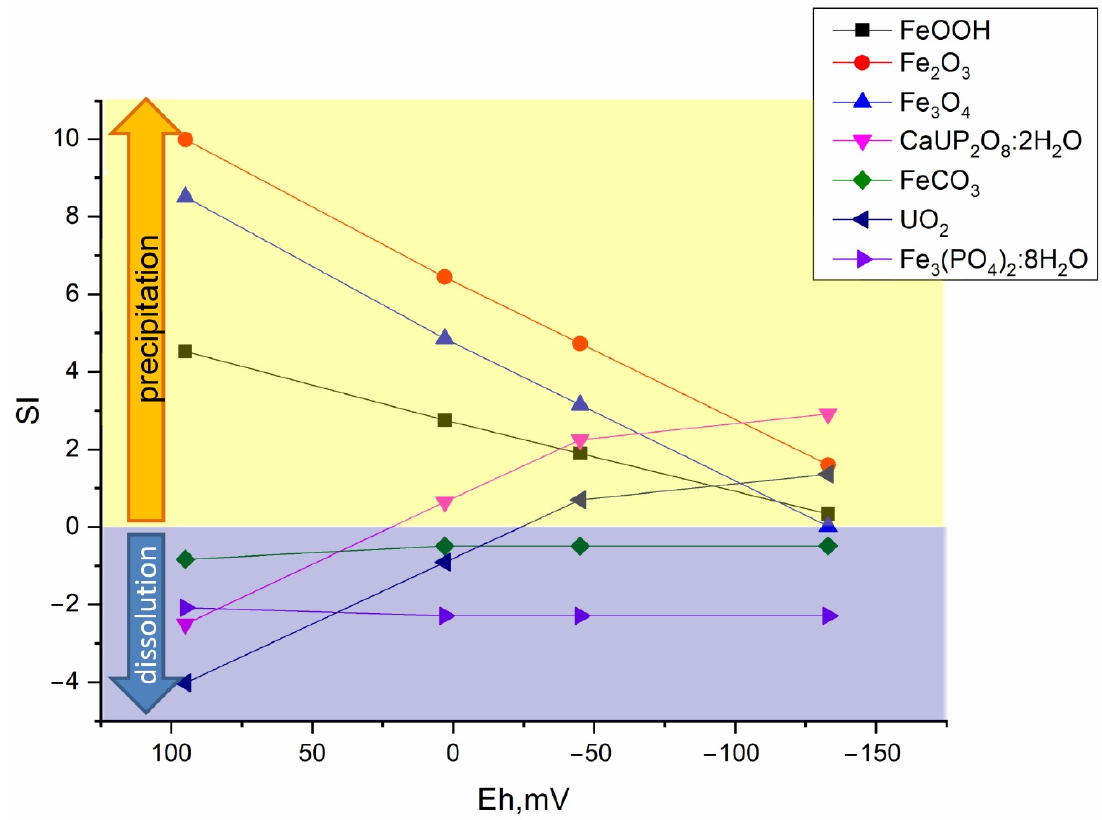
Figure 8. Distribution of main mineral phases before and after microbial processes in the Ammophos sample.